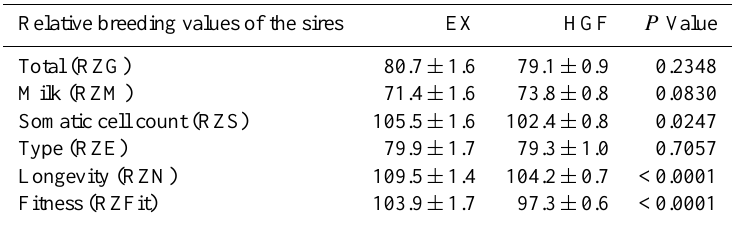
Table 4. Least-square means (LSMs) with their standard errors for relative breeding values of sires of the exceptional cows (EX) and contemporary herdmates (HGF) as well as P values for differences among LSMs using model